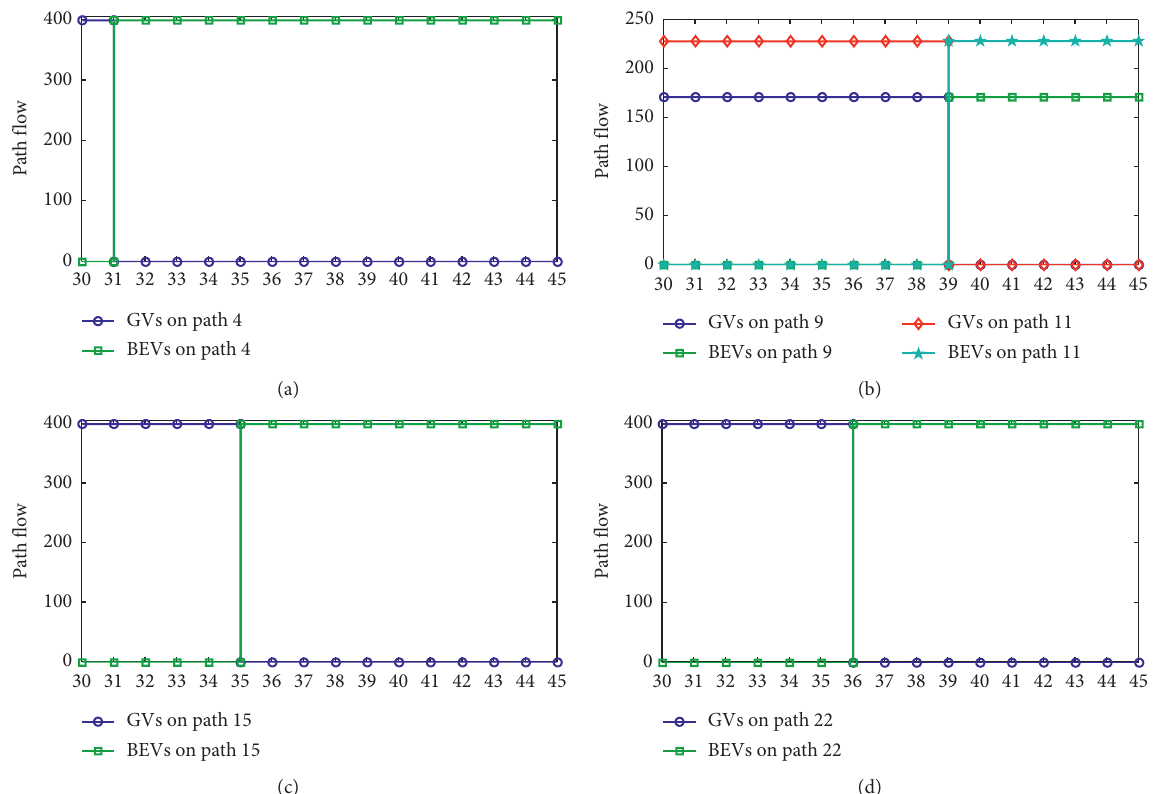
Figure 4: Changing distance limit of BEVs of each O-D pair in Nguyen–Dupuis’ network. (a) O-D pair (1, 2). (b) O-D pair (1, 3). (c) O-D pair (4, 2). (d) O-D pair (4, 3).